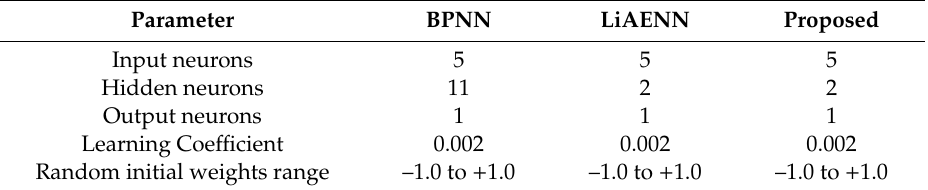
Table 3. The final training parameters used in the BPNN-based model, the limbic-based artificial emotional neural network (LiAENN)-based model, and the proposed